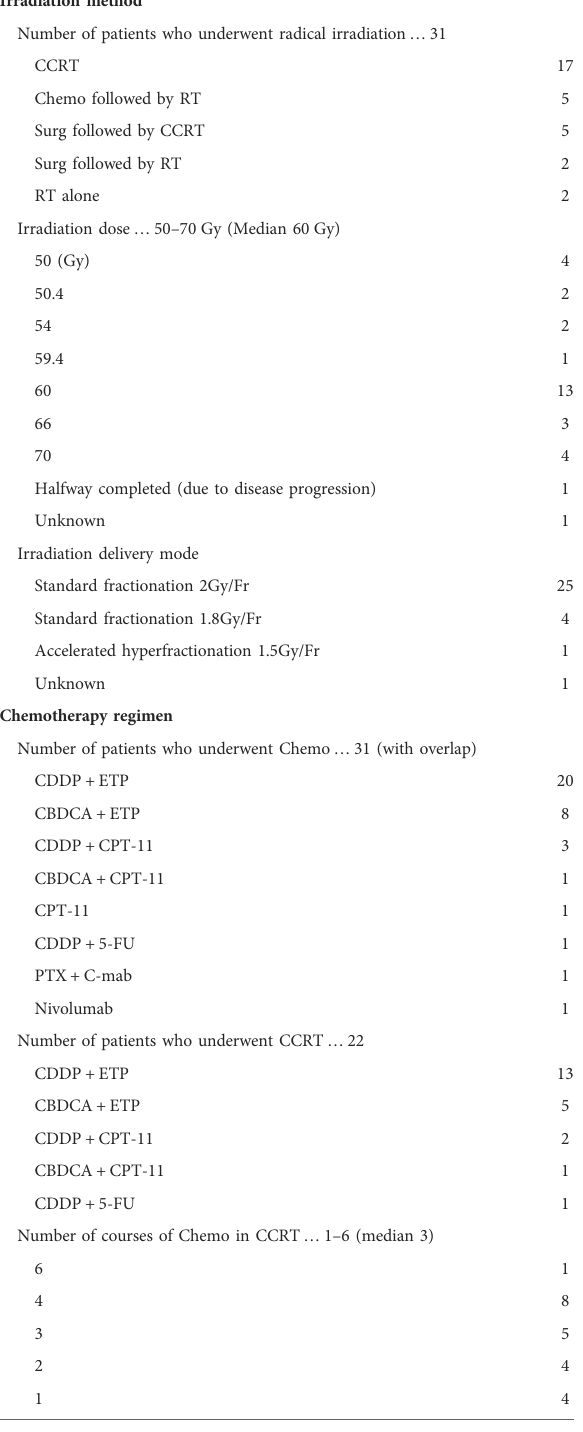
TABLE 5 Irradiation method and chemotherapy